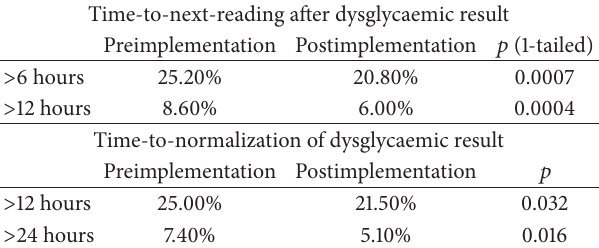
Table 2: Proportion of values for time-to-next-reading and time-to- normalization values above specified